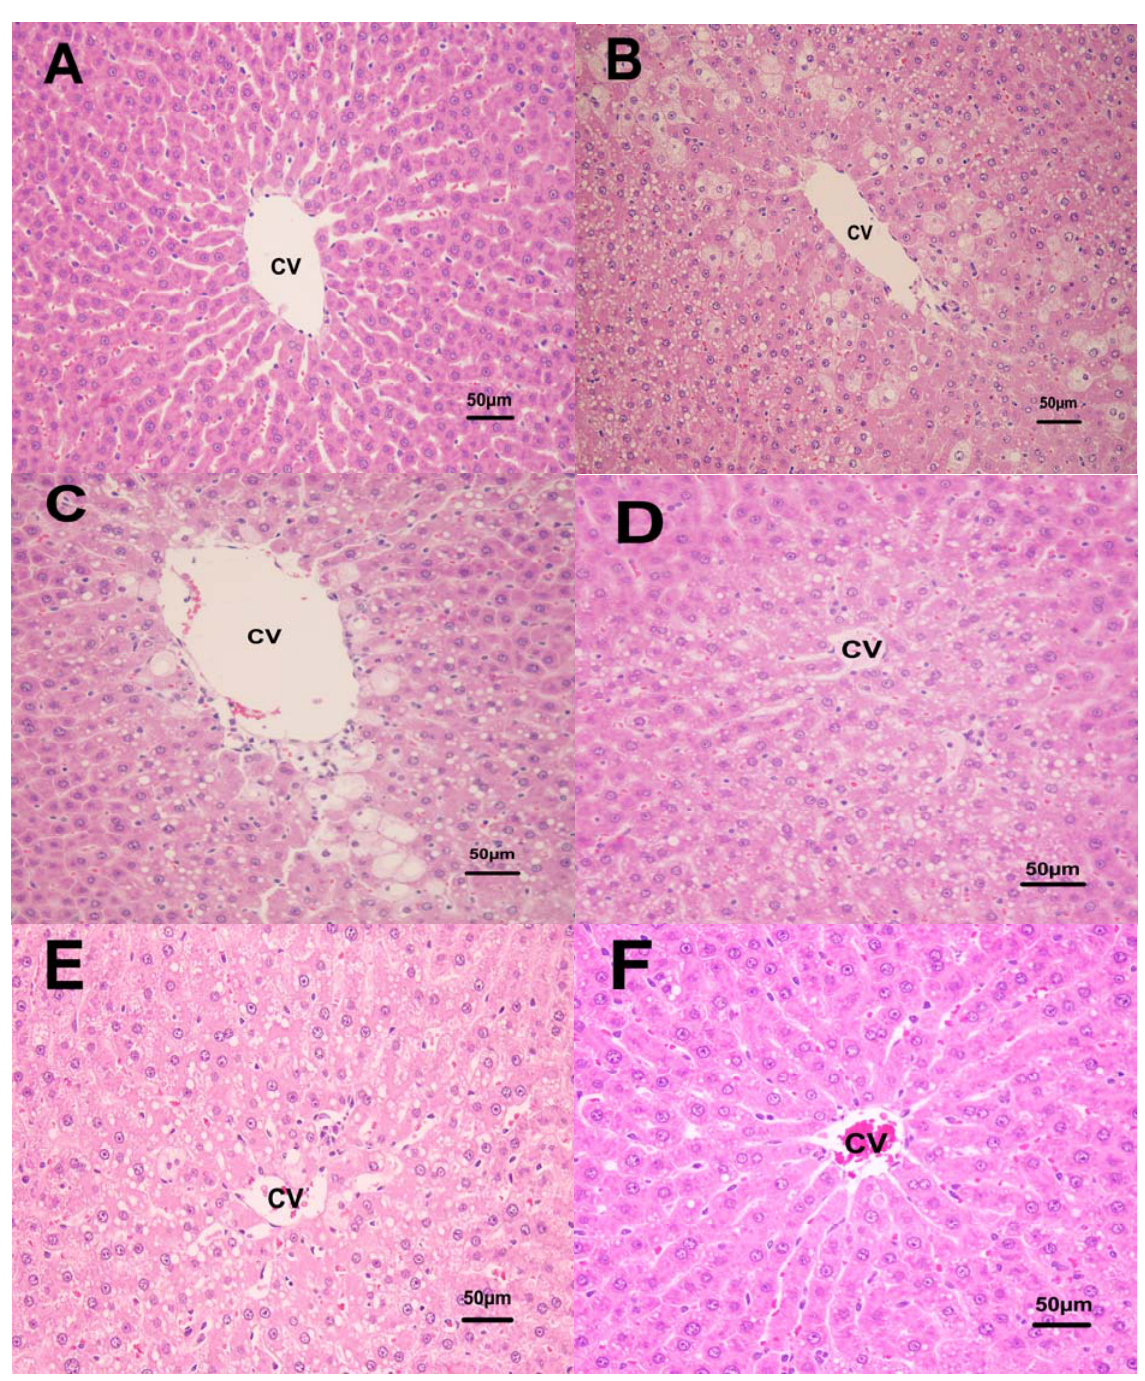
Figure 4. Histopathological changes of the liver (H and E, 200×) (A) normal control group, (C-E) extract treatment groups (CCl group, (B) CCl 4 mg/kg, respectively), (F) AC (2,000 mg/kg) alone, (G-I) extract treatment groups (CCl + QI 500, 1,000 and 2,000 mg/kg, respectively), (J) QI (2,000 mg/kg) alone and (K) 4 CCl + silymarin (100 mg/kg) (CV, central 4